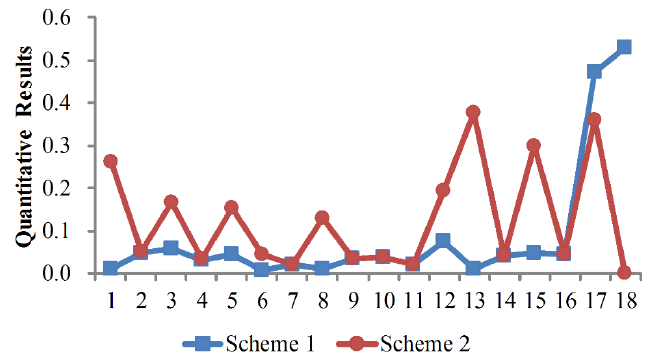
Figure 7. Comparisons of quantitative results of vulnerabilities in different